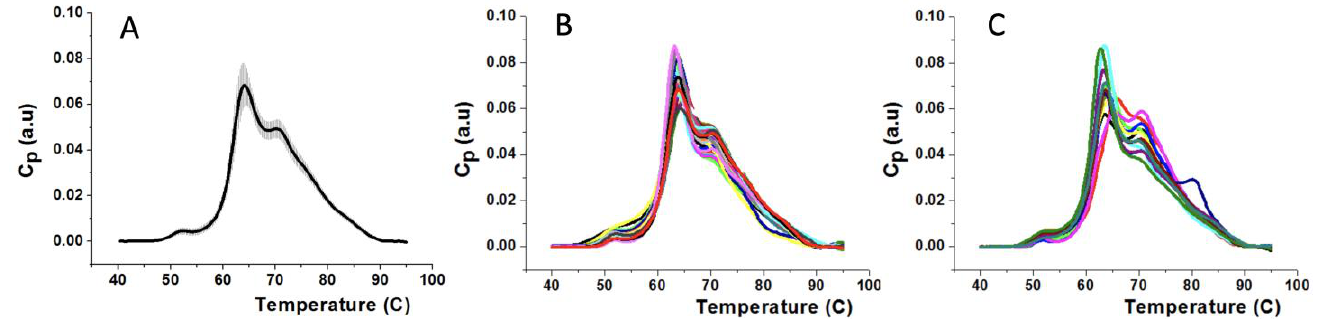
Figure 2. Thermogram comparison. ( A ) Average and standard deviation of the 40 thermograms from the HC group; ( B ) thermograms from 20 MS patients with EDSS ≤ 3.0; and ( C ) thermograms from 20 MS patients with EDSS >